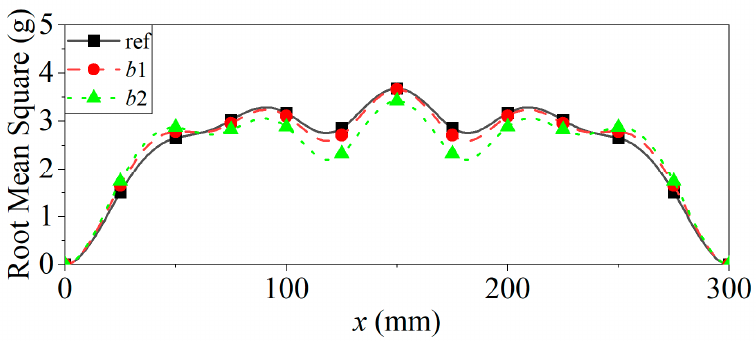
Figure 10. RMS of acceleration in the z-direction under different thermal loads.